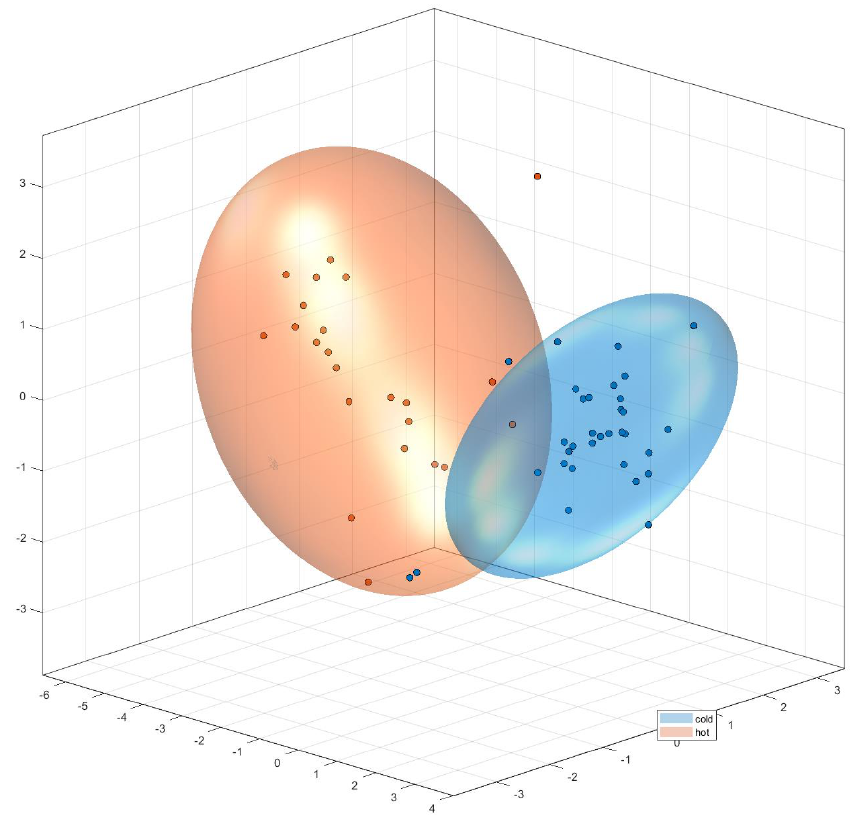
Figure 9. Principal component analysis (PCA) of hot (red) and cold (blue) brew coffees.